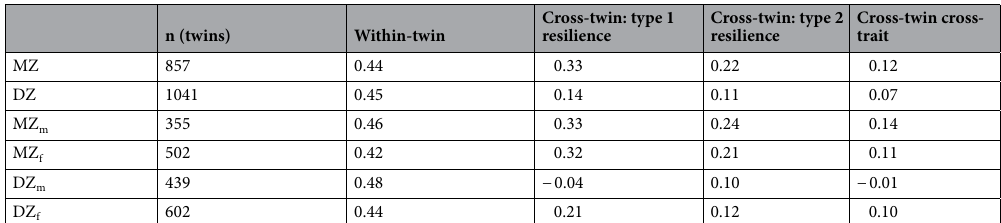
Table 2. Twin correlations for type 1 and type 2 resilience: within-twin correlations, cross-twin correlations and cross-twin cross-trait correlations by zygosity.